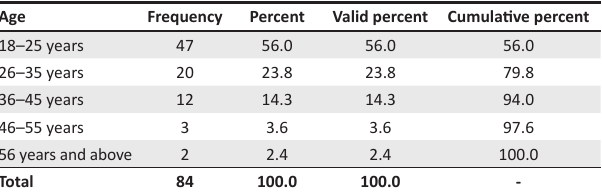
–0.30–0.25–0.20–0.15–0.10–0.0500.050.100.15